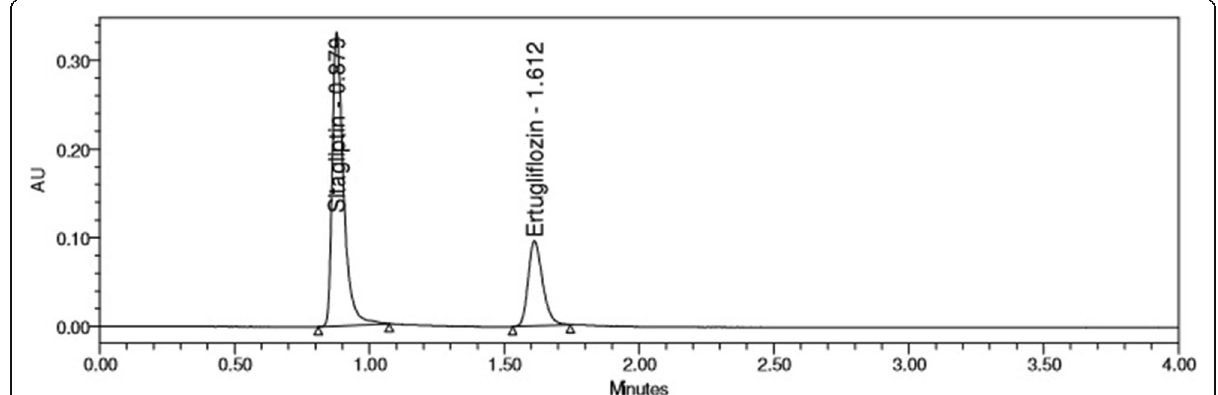
Fig. 4 Chromatogram of marketed formulation